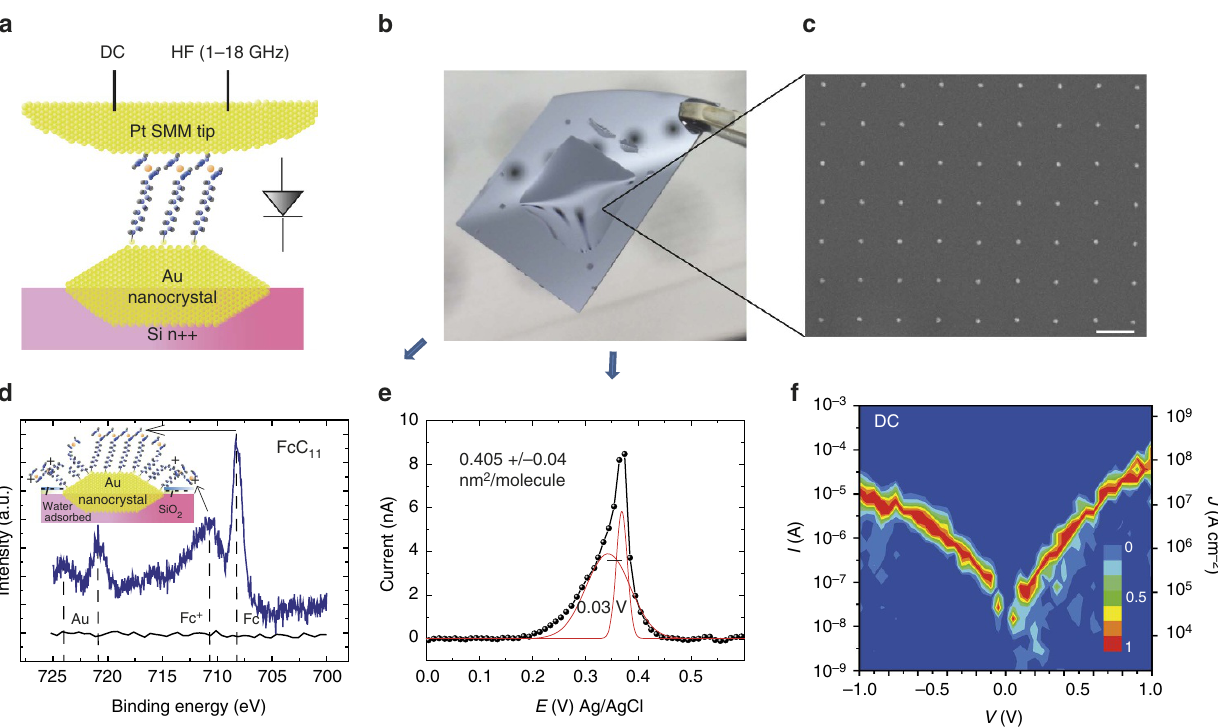
Figure 1 | Description/characterization of the RF molecular rectifier. ( a ) Schematic representation of the molecular junction composed of a gold nanocrystal, Ferrocenyl undecanethiol (FcC 11 ) molecules enabling rectification properties, and a Pt tip. Nanocrystals form an ohmic contact to a highly doped silicon substrate. The Pt tip is biased (through a bias-T) to both d.c. and HF (1–18GHz) excitation simultaneously. ( b ) Picture of a 1cm (cid:2) 1cm array of gold nanocrystals used for X-ray photoemission spectroscopy (XPS) or Cyclic Voltammetry measurements. The picture is taken just after dipping the sample into HF (for removal of the SiO 2 covering dots), the gold nanoarray area being identified through an hydrophilic/hydrophobic contrast. ( c ) Gold nanodot array imaged by Scanning Electron Microscope (SEM). Scale bar, 200nm. ( d ) XPS measurements for SAMs of FcC 11 grafted on gold nanocrystals ( B 1 billion dots fabricated by high-speed lithography) showing the presence of a Fe doublet related with ferrocene at 707.8eVand 720.7eV (Fe 2 p 3/2 and Fe 2 p 1/2 , respectively), anda Fe doublet related to ferricenium at at 710.6eV at 723.9eV (2 p 3/2 and 2 p 1/2 , respectively). The XPS signal for the bare Au nanoarray is also shown as a reference. Inset: schematic representation of the SAM with Ferricenium molecules located at dots borders due to the presence of a negatively charged silica. ( e ) Cyclic voltammetry measurements supports the presence of ferrocenyl molecules on the nanodots with a double peak at E ¼ 0.34V and 0.37V versus Ag/AgCl as a reference electrode in agreement with previous studies 15 . ( f ) 2D histogram (normalized to 1) showing the I–V (and J–V ) curve from one hundred junctions on 20nm gold nanoparticles. The voltage step is 0.1V, and the 2D histogram is obtained by the contour plot function (Originlab). The applied load was 18nN (see Supplementary Note 4 for a detailed discussion on the tip